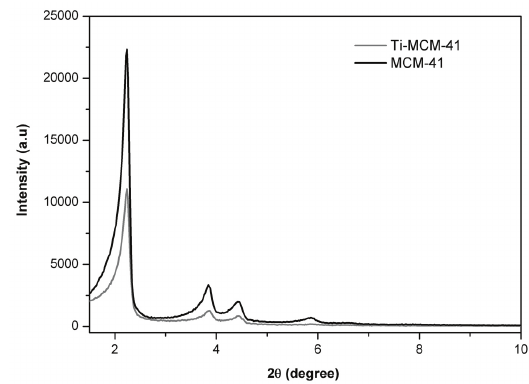
Figure 1. X-ray diffractogram of calcined MCM-41 and Ti- MCM-41.